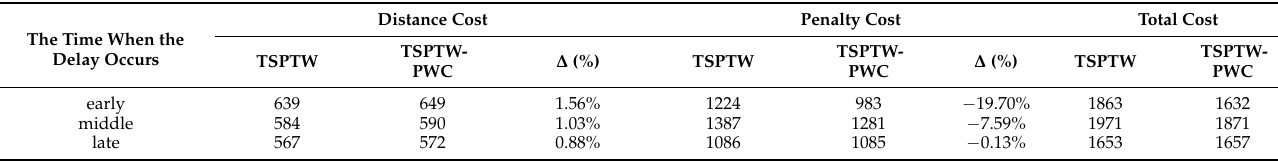
Table 5. Sensitivity analysis of delay occurring